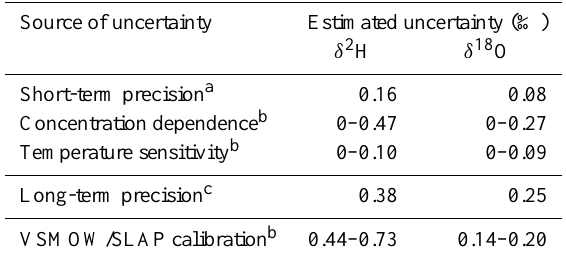
Table 1. Different sources of uncertainty contributing to the overall performance.